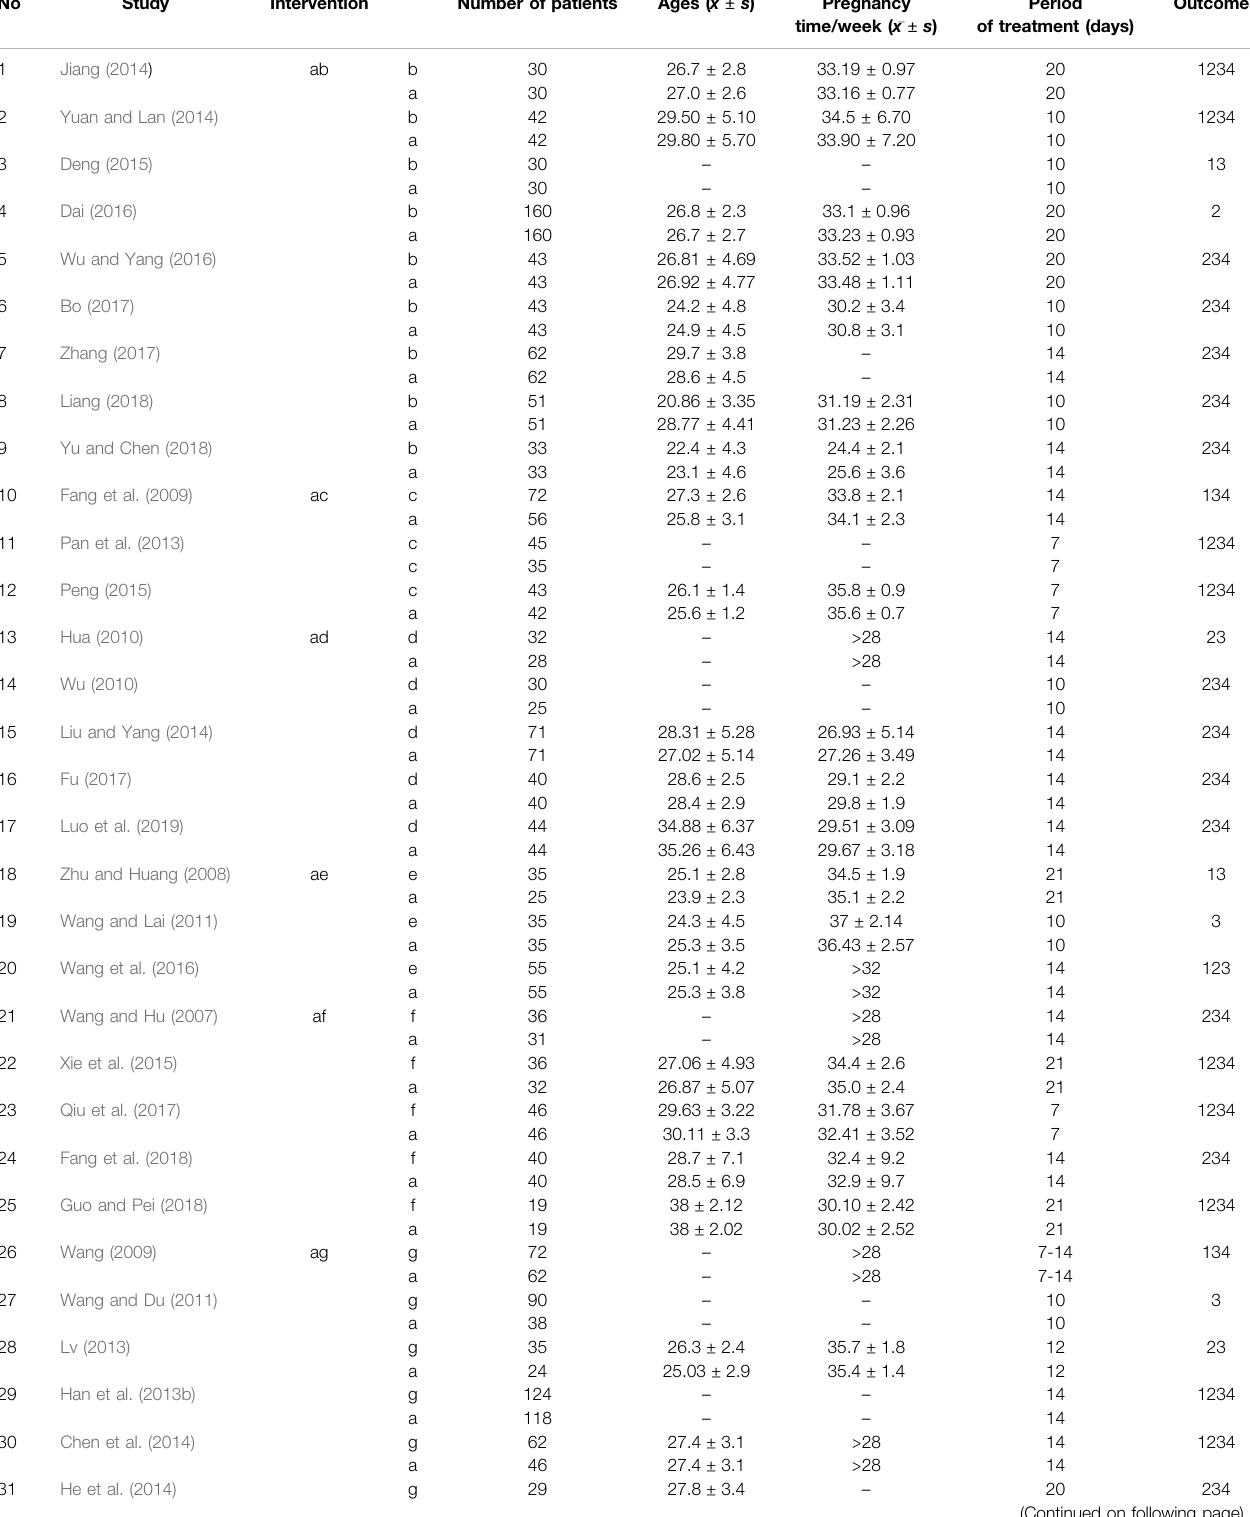
TABLE 3 | Basic characteristics of randomized controlled trials included in network